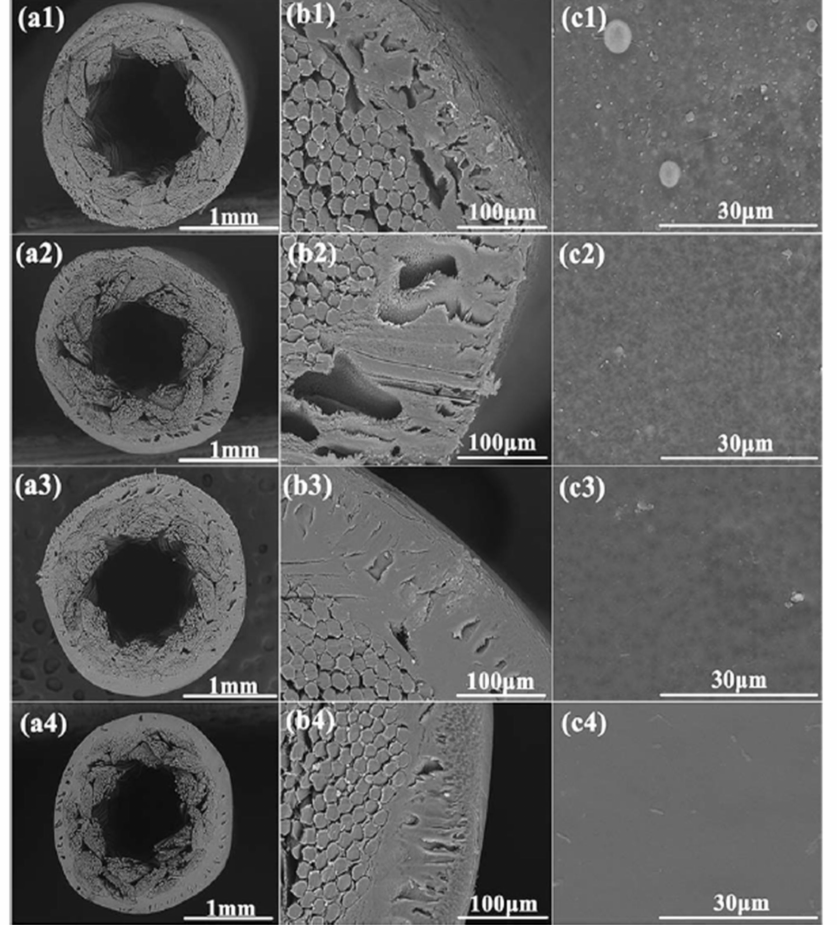
Figure 23. BRHF membrane morphology: ( a ) cross-section;( b ) cross section partial enlargement; ( c ) outer surface of ( 1 ) PMIA5 ( 2 ) PMIA8 ( 3 ) PMIA10 ( 4 ) PMIA15 [228]. Reprinted/adapted with permission from Ref. [228]. Copyright 2022, Royal Society of